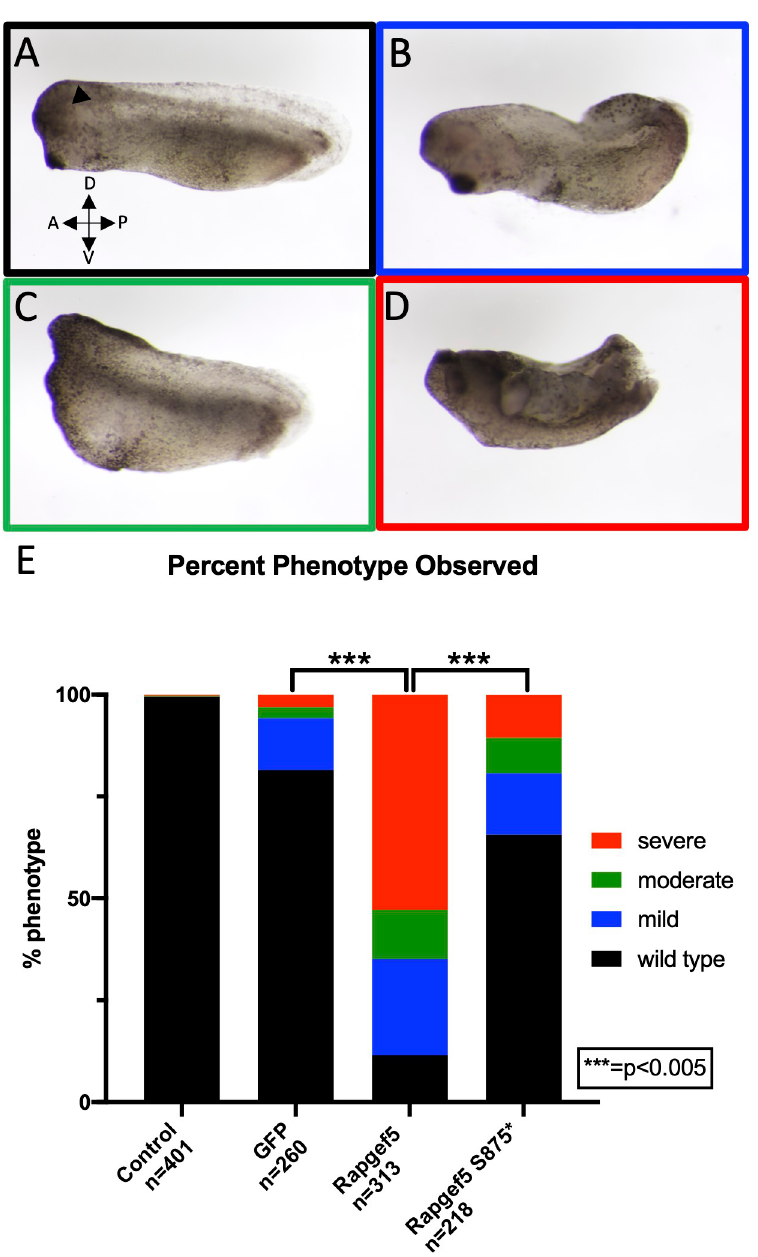
Fig 5. Overexpression model in Xenopus identifies the equine RAPGEF5 variant as a loss-of-function allele. Overexpression of equine RAPGEF5 mRNA affects embryonic development in Xenopus tropicalis ; however, the equine S875 � RAPGEF5 variant has a dramatically diminished effect. (A) Normal development in uninjected control X . tropicalis embryos. All embryos are lateral views with anterior to the left and dorsal to the top. (B) Mildly affected development. Embryos display compromised elongation along anterior-posterior axis and a delayed formation of eyes and tail. (C) Moderately affected development. Most notably in this category embryos fail to form head structures (D) Severely affected development. Embryos display incomplete blastopore closure, incomplete neurulation, compromised elongation along anterior-posterior axis, and absence of distinguishable head structures. (E) Quantification of the phenotypes of the uninjected, equine RAPGEF5 mRNA injected, and equine S875 � RAPGEF5 mRNA injected embryos classified as wildtype, mild, moderate, and severe at stage 28. Data is a compilation of three independent experiments. ( ��� p < 0.0005). A = anterior, P = Posterior, D = Dorsal, Black triangle = filled arrowhead points to location of eye.